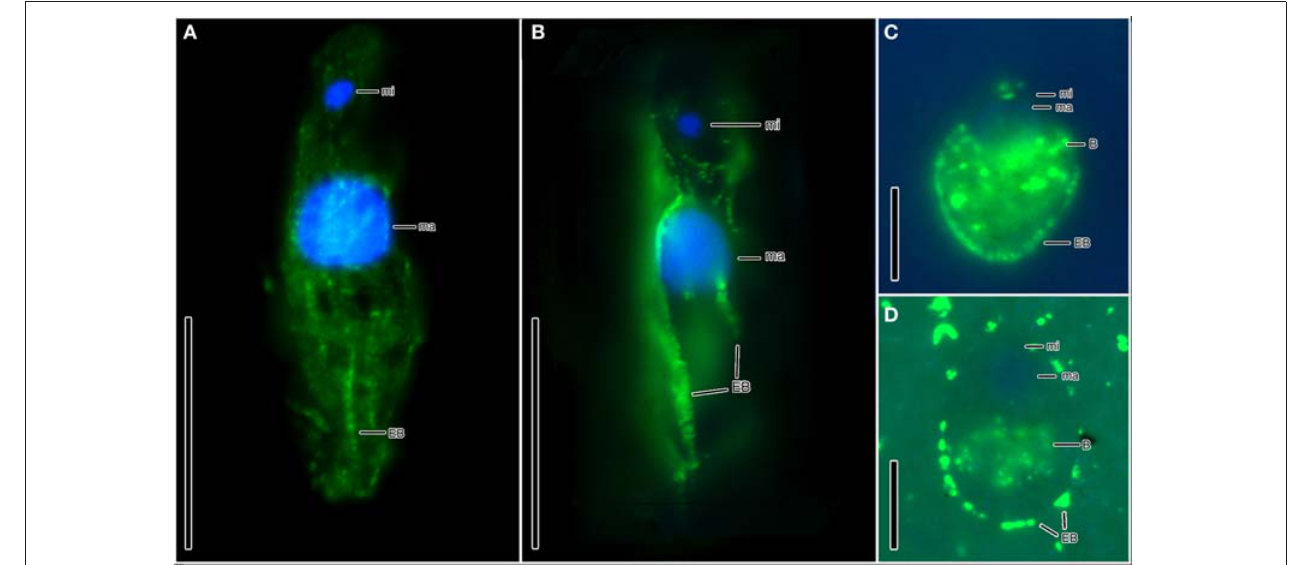
FIGURE 3 | Hybridization of CARD-FISH probes to bacterial epibonts attached to ciliates from Discovery (A,B) and Urania (C,D) haloclines. (A) Epifluorescence of the EUB I-III CARD-FISH probe confirming that the microbes attached to the cortex of a ciliate from Discovery halocline are Bacteria. (B) Epifluorescence of a CARD-FISH probe specific to Delta-proteobacteria, confirming that the microbes attached to the